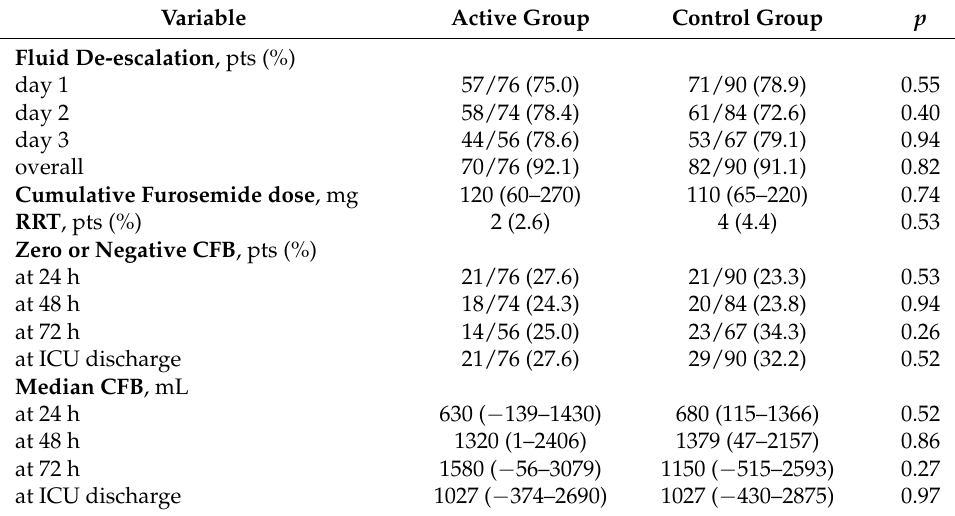
Table 4. Fluid de-escalation measures and CFB across groups.